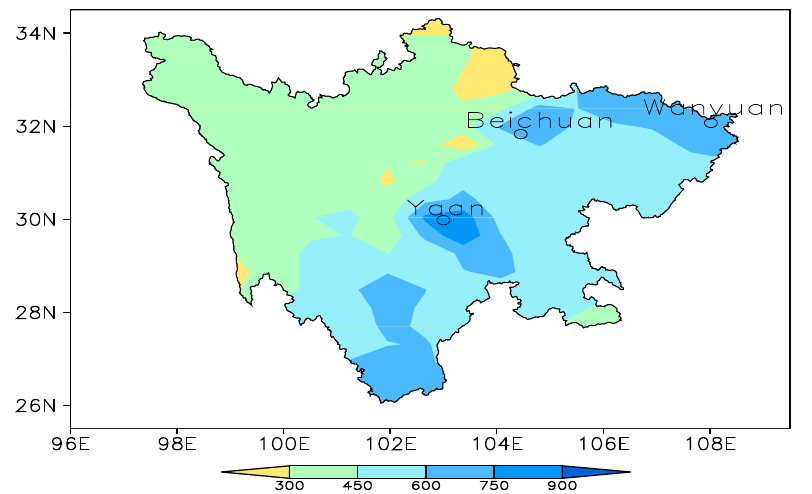
Figure 3. Spatial distribution of summer mean precipitation in the Sichuan from 1979 to 2016 (shadow; unit, mm; black circles are representative stations of the three precipitation centers in the basin).